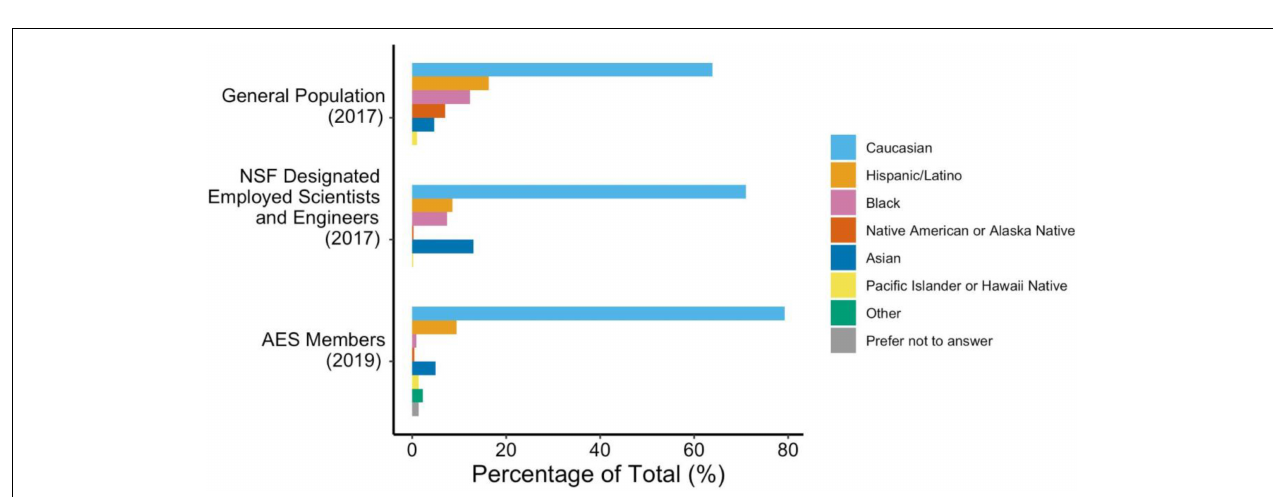
FIGURE 3 | The race/ethnicity of AES members compared with National Science Foundation